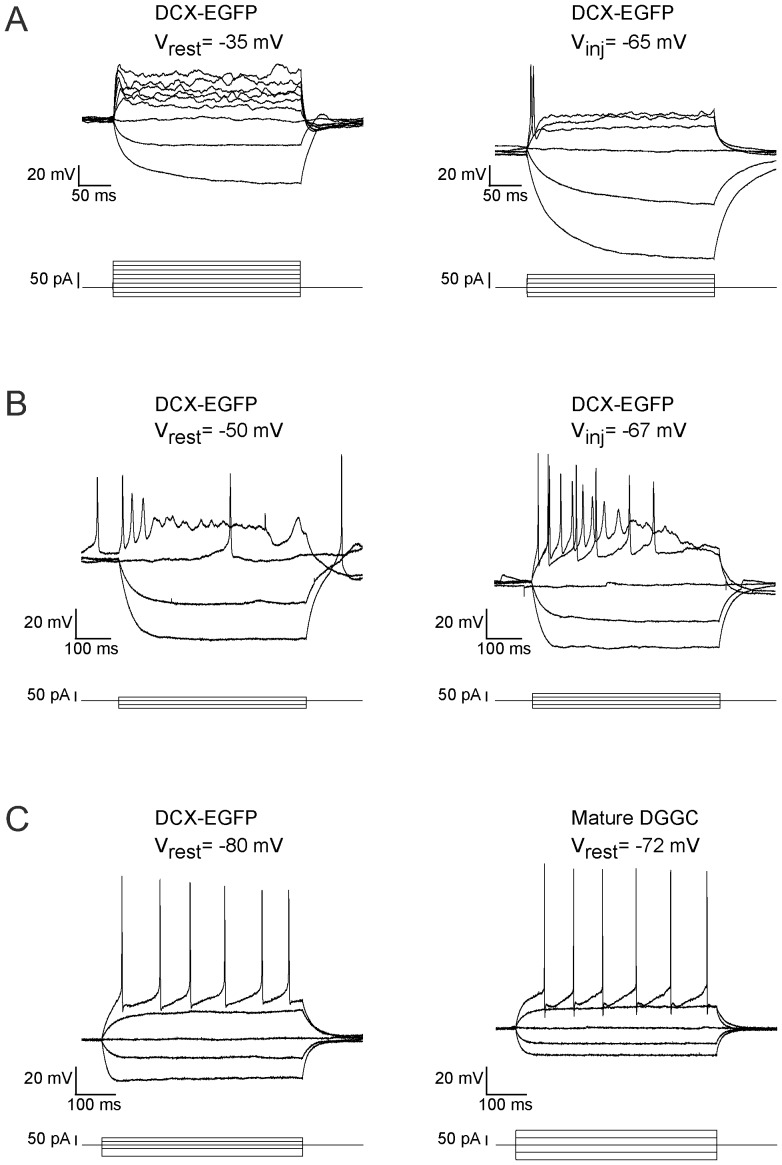
Firing Properties of EGFP-expressing Granule Cells.The firing properties of EGFP-expressing granule cells in the DCX-EGFP mouse indicate that the cells are at various stages of electrophysiological maturation. A. The majority of recorded cells had an apparent (though inaccurately measured, see text) depolarized resting membrane and failed to fire an AP (left) during successive depolarizing square-pulse current injections (corresponding current injections are indicated below each set of voltage traces). However, when a hyperpolarizing current was used to artificially maintain a more negative resting membrane potential some cells were capable of firing a single AP (right). B. Some EGFP-expressing granule cells were capable of firing more than one AP from rest (left) and could be converted to firing multiple APs when artificially maintained at a more negative resting potential (right). C. A few EGFP-expressing granule cells fired sustained trains of APs (left) like mature granule cells (right). These cells were often dim in comparison to the first group, and located a couple of cell layers from the SGZ towards the molecular layer. Mature granule cells were recorded at the outer lip of the granule cell layer adjacent to the molecular layer. In each panel (A–C) both sets of traces (left and right) are plotted on the same y-axis for that panel.